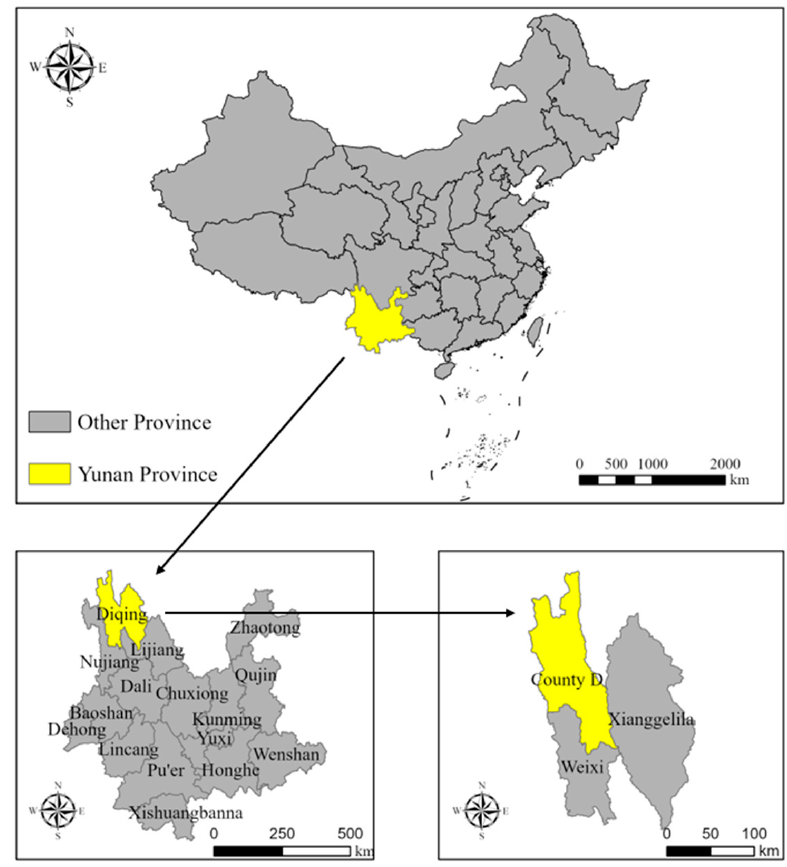
Figure 1. Study area.